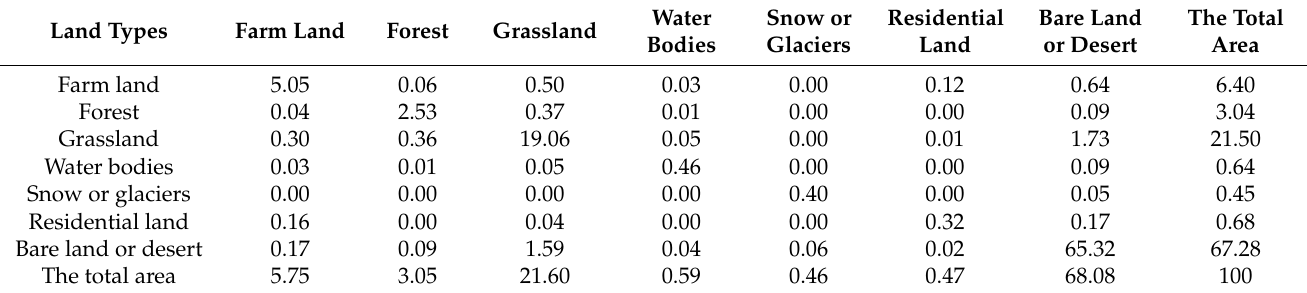
Table 1. Transfer matrix of land use types in the oases of the Hexi Corridor from 2000 to 2020.